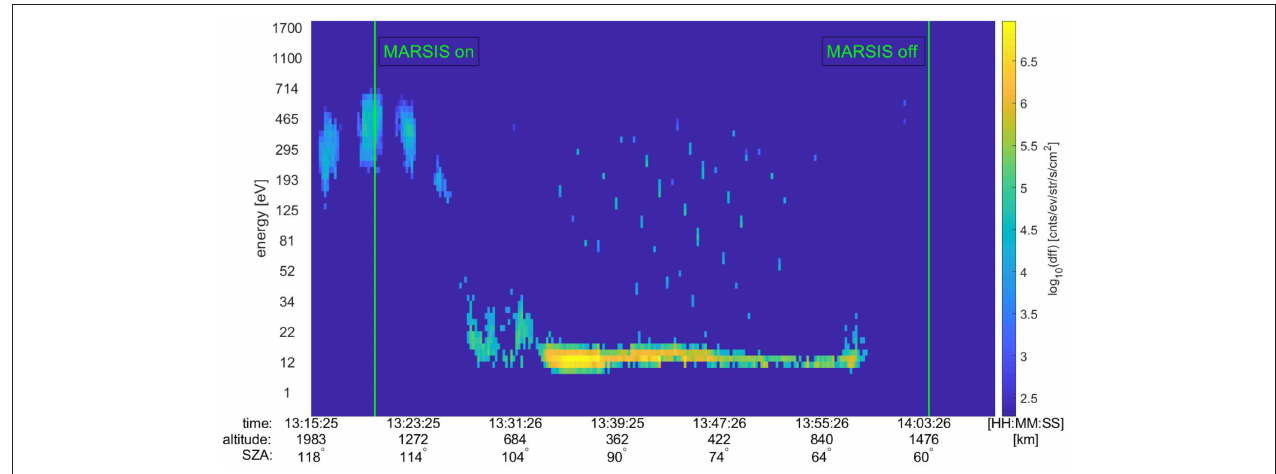
FIGURE 1 | Differential flux of O + ions measured by the ASPERA-3 IMA sensors on 22-03-2012 from 13:15 to 14:09 UTC.